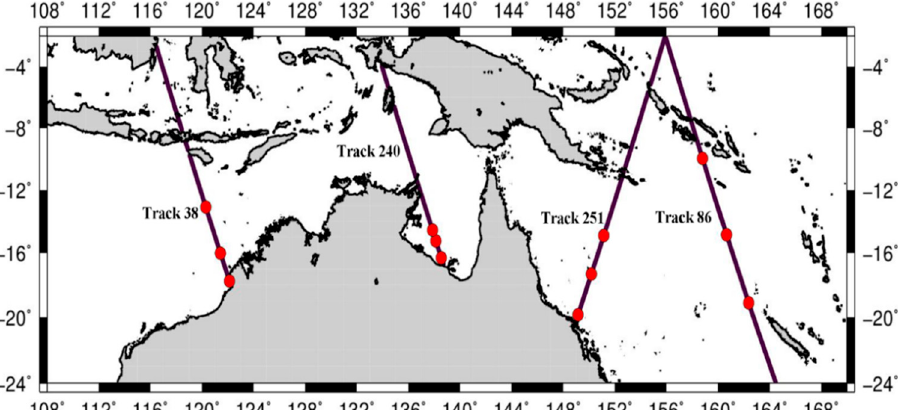
Figure 3. Locations of 12 altimetry ground track points considered to study spectral analysis in deep ocean and shallow-water areas.